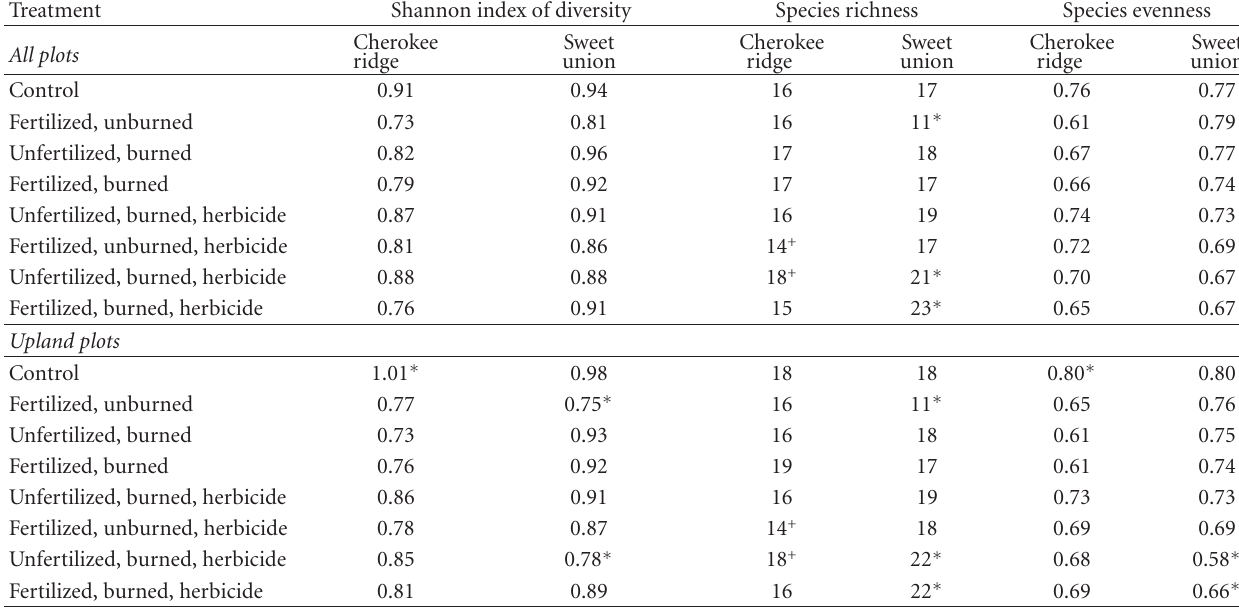
Table 5: Site-specific understory measures of alpha diversity, cherokee ridge, and sweet union research sites, east Texas, USA. ∗ significantly di ff erent from all other treatments within column; + significantly di ff erent from the other site from analysis of various test proc GLM (SAS, ver 8).